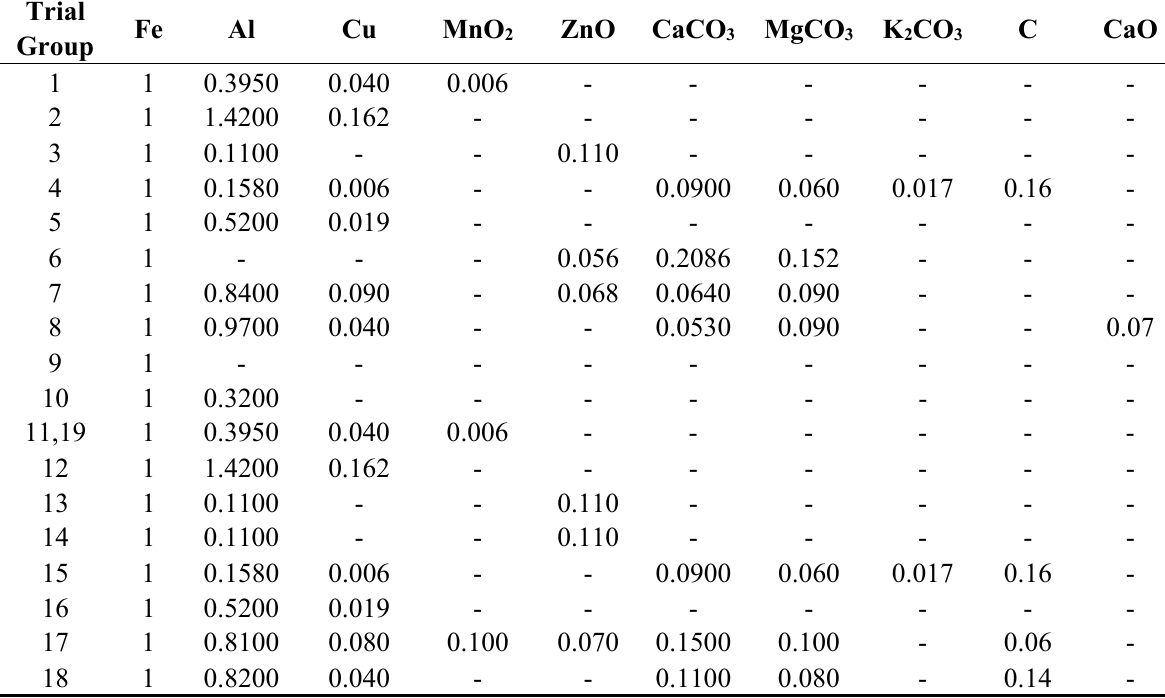
Table D2. ZVM molar compositional ratios used to manufacture ZVM TP. Data in Table 1